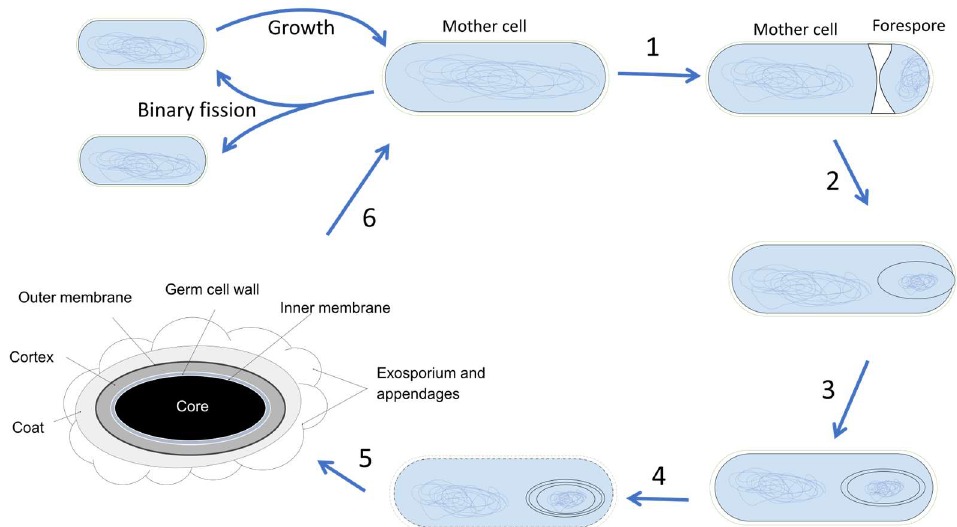
Figure 1. Structure of Clostridium botulinum spore and the key stages of sporulation: (1) Asymmetric division: vegetative cells normally divide by binary fission, and under stress conditions, they start sporulation process by initiating asymmetric division. (2) Engulfment: the newly emerged forespore is engulfed by the parent cell. (3,4) Cortex and coat formation: the cortex is formed around the forespore, and the coat starts depositing from mother cell membranes. (5) After maturation of the endospore, mother cell lysis occurs, releasing a dormant spore (structure shown with labels). (6) Germination: the spore germinates into a new bacterial cell under favorable conditions.